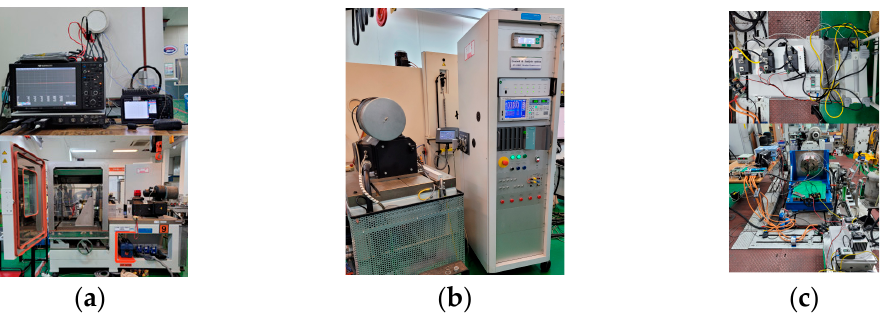
Figure 24. ( a ) Oscilloscope, temperature data logger, and temperature/humidity chamber coupled dynamo test bench, ( b ) Power analyzer for counter EMF measurement, ( c ) Semi-EMF demagnetization-ratio experimental environment and diamagnetic current-application device.